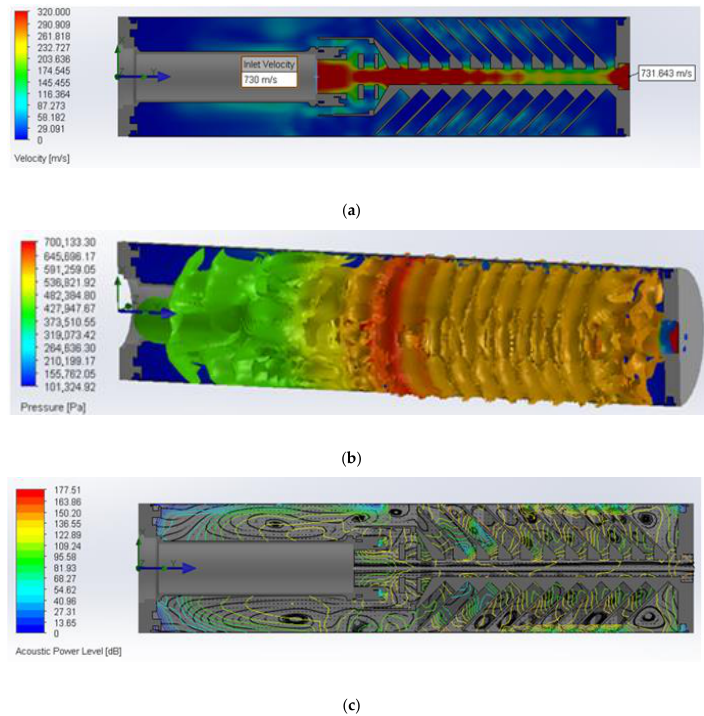
Figure 3. Longitudinal velocity distribution ( a ), geometric pressure distribution ( b ) and sound pressure distribution and flow lines ( c ). Analyzing the pressure distribution in the geometry, a decrease in values is observed after the first space deflection, in which eddies are generated, reducing the energy of the expanding gas (Figure 3b). However, the last three partitions show a decreasing pressure field, as the length of the structure may not be optimal, but good damping parameters are maintained. The results defining the sound pressure distribution show vortex zones in the parti- tion spaces in the expansion zone, where the maximum efficiency of the structure in con-